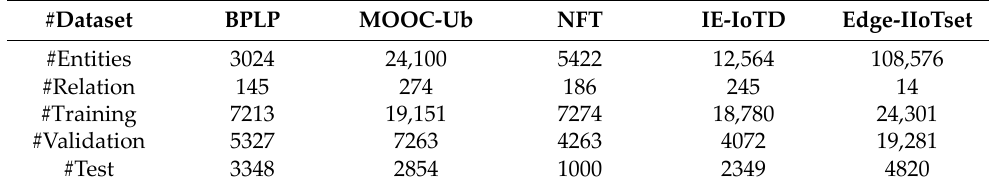
Table 2. Summarizes the statistics of the